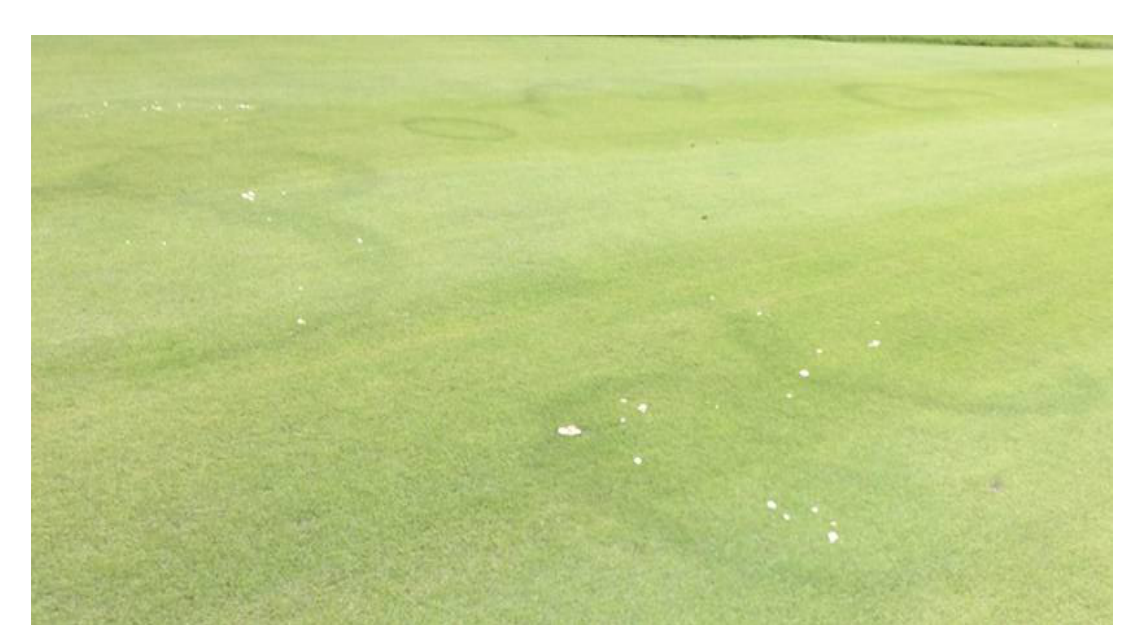
Figure 1. Fairy rings appearing on golf course grass.